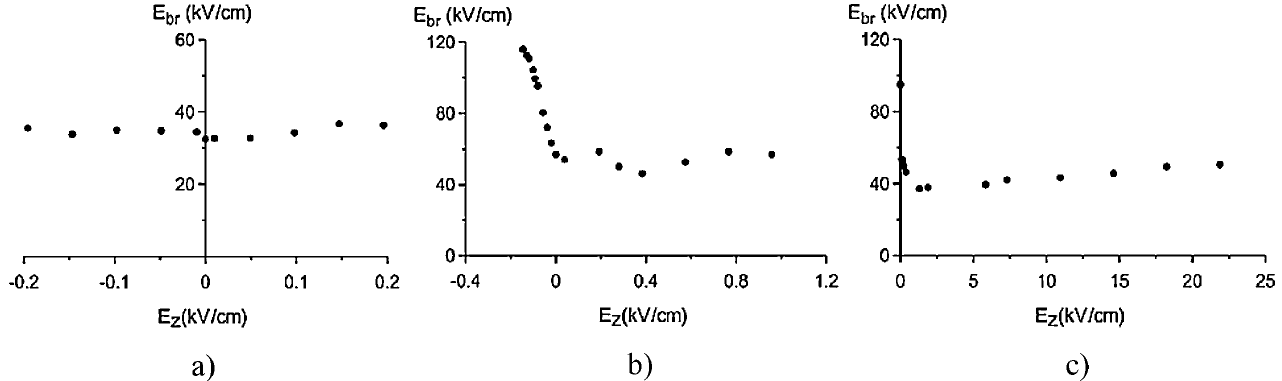
FIG. 6. Dependence of the multipactor threshold on the amplitude of the electrostatic field for quartz disks having different thicknesses and directions of the ponderomotive force, F (cid:3) : (a) d 1 ¼ 2 : 3 mm , F (cid:3) < 0 , (b) d 2 ¼ 4 : 2 mm , F (cid:3) ¼ 0 , (c) d 3 ¼ 6 mm , F > 0 (cid:3)